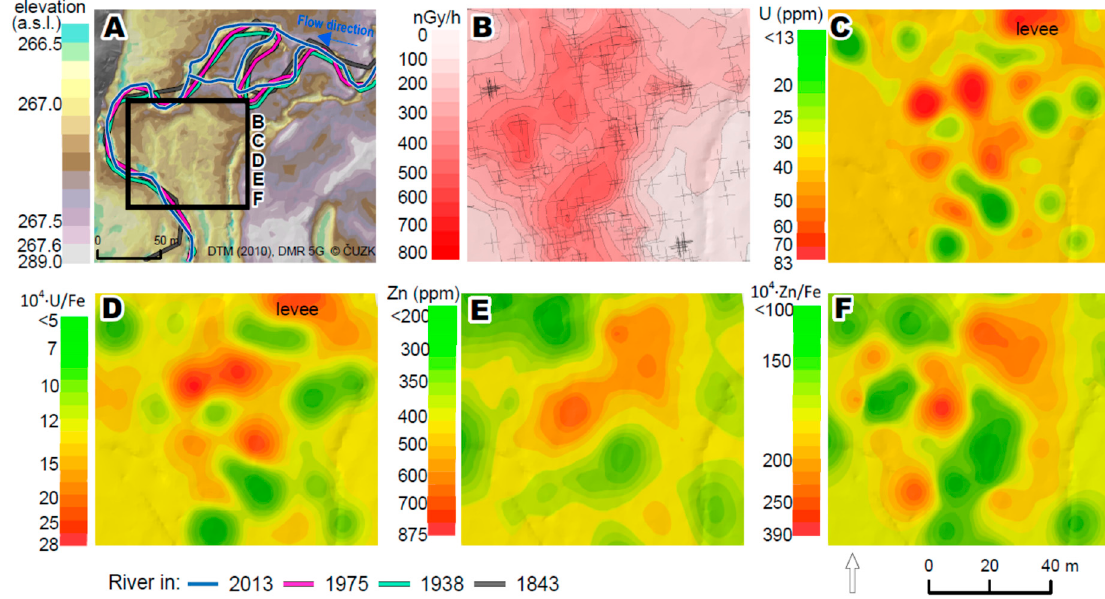
Figure 9. The MH–Boreˇcek study area. Digital terrain model (panel A ), gamma activity map (panel B ), XRF maps of U (panel C ) and the U/Fe ratio (panel D ), and XRF maps of Zn (panel E ) and the Zn/Fe ratio (panel F ). Historical channel positions are also shown.